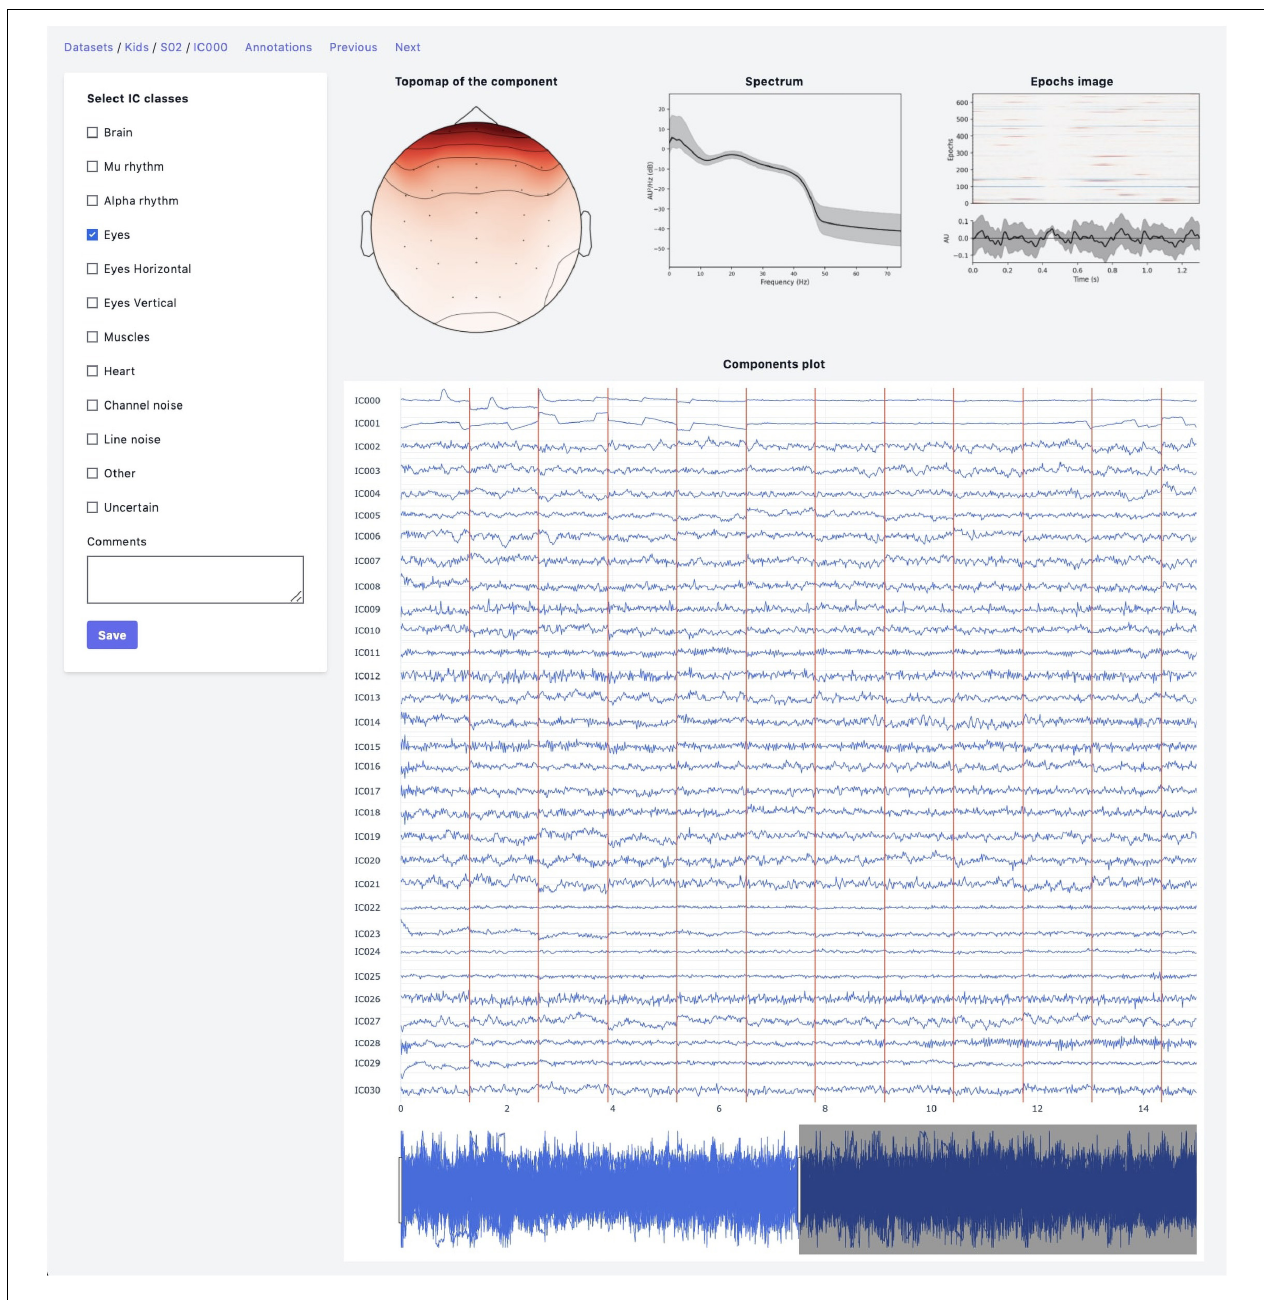
FIGURE 2 | Annotation module interface. Top row: IC topomap and spectrum as well as Epochs image, illustrating the color-coded amplitude fluctuations (arbitrary units) of the IC in all available epochs (time relative to sound presentation on the x -axis, epochs on the y -axis). Image at the bottom shows averaged values of ICs timeseries; bottom row: all IC for considered subject are plotted